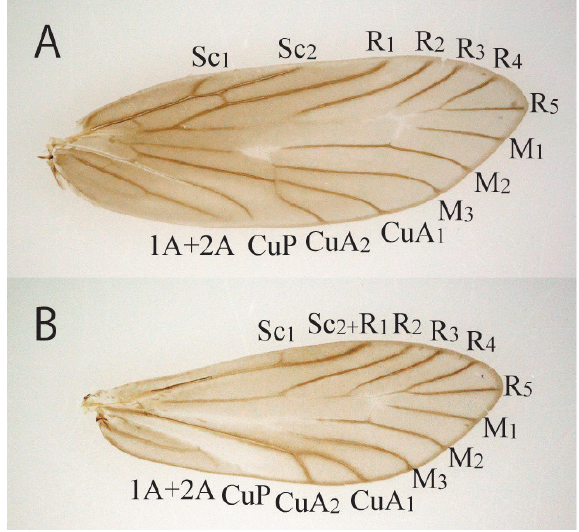
Figure 3. Adult wings of Melinopteryx coruscans sp. n. A: right forewing; B: right